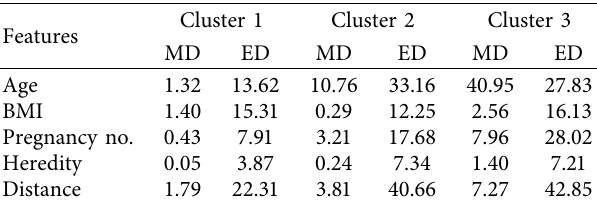
Figure 4: Calculate distance of new sample to clusters by MD. Table 4: The comparison of the calculated distance between the new sample and each cluster by Mahalanobis and the Euclidean